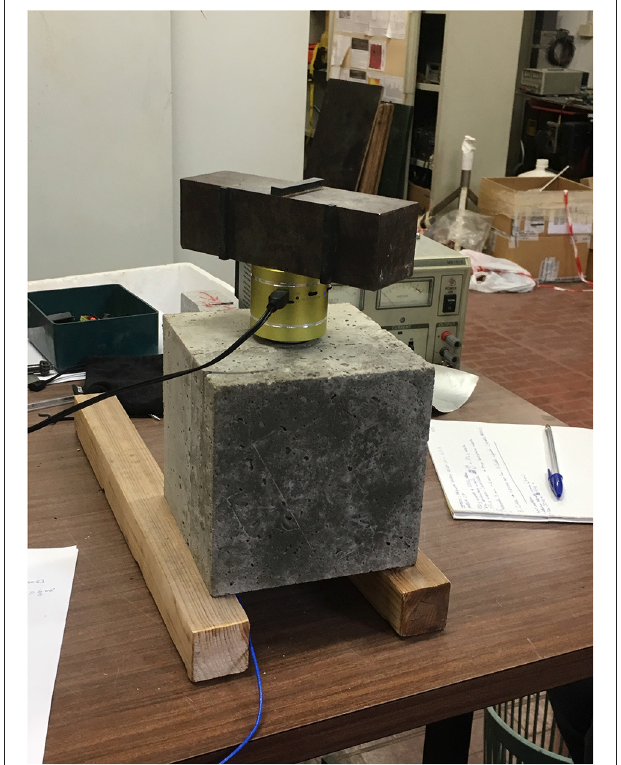
FIGURE 3 | Experimental setup, showing a metaconcrete specimen, the two transducers, and the vibration speaker pressurized with a weight to increase